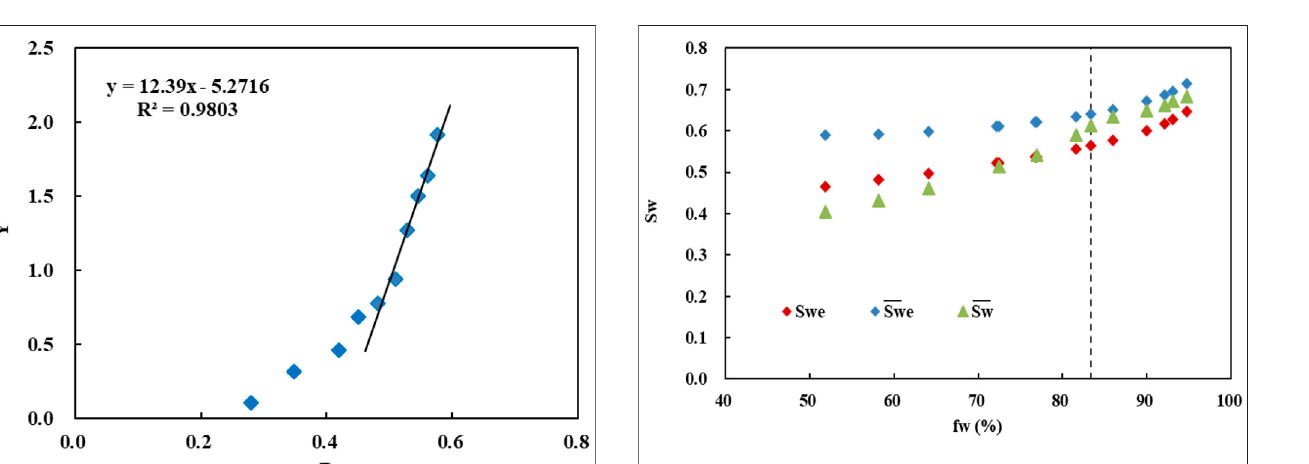
FIGURE 4 | The relation curve of three kinds of water saturation with water cut.